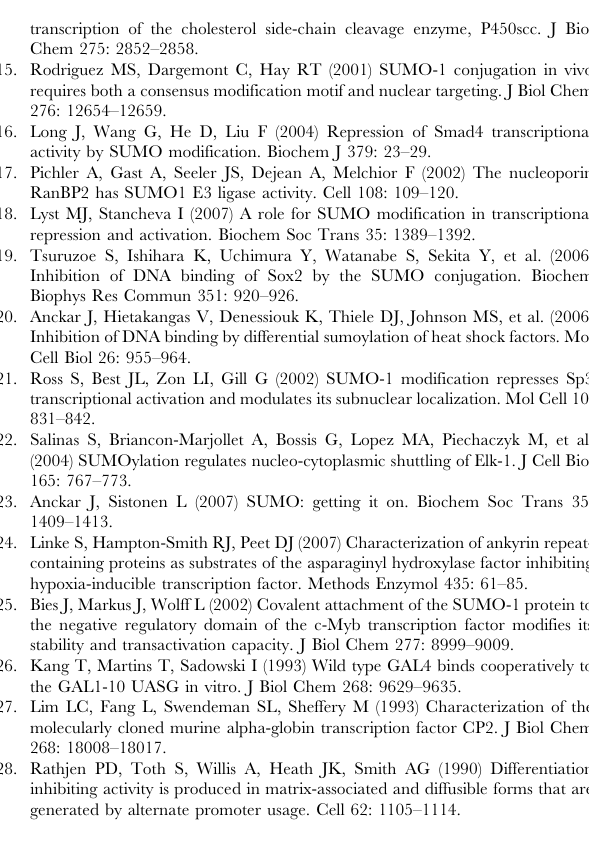
Figure S3 A. This is a re-probing of the blot from Fig. 6C with anti-CRTR-1 antibody to demonstrate that CRTR-1 is success- fully immunoprecipitated and that levels of wild-type and sumoylation-mutant CRTR-1 proteins are expressed at compara- ble levels. B. Western blot analysis of ES cells transfected with the indicated amounts of pEF-CRTR1, pEF-K30A, pEF-K2A or pEF-K464A and pTK-4xWT-CP2-LUC reporter construct (ng). Cells were lysed 48 h post-transfection and 20% of total cell lysate was analysed. The upper panel shows membrane probed with rabbit anti-LBP-9 antibody (LS-C30155, LifeSpan Biosciences, 1:500) to detect CRTR-1 (arrow) using enhanced chemifluores- cence. The lower panel is re-probing of the membrane with rat anti-alpha-tubulin antibody and detection using chemilumines- cence. Found at: doi:10.1371/journal.pone.0011702.s003 (0.33 MB